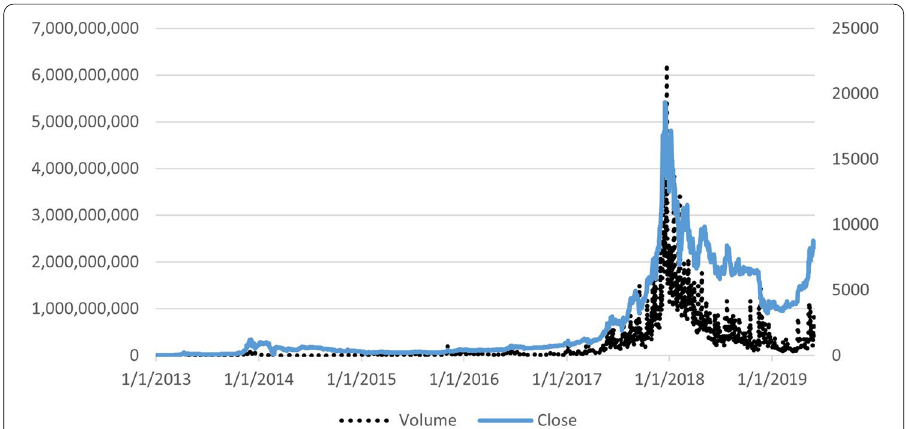
Fig. 1 Daily trading volume (left axis) and closing price of Bitcoin (right axis, in US